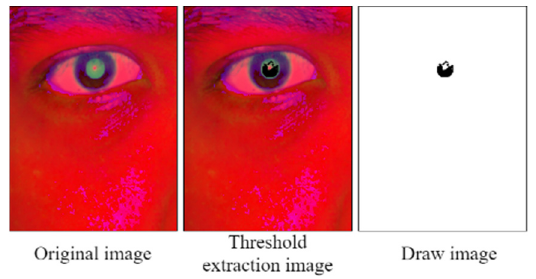
Figure 41. Pixel coordinate image obtained with the PRSSM-based pupil diameter analysis mod- ule.